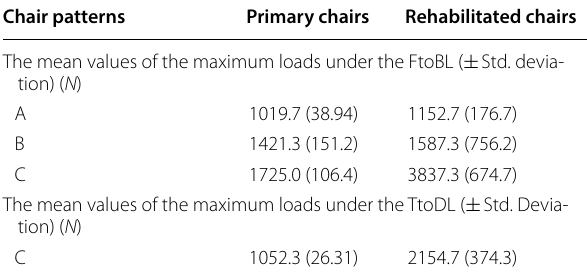
Table 4 The mean values of the maximum loads carried by primary and rehabilitated